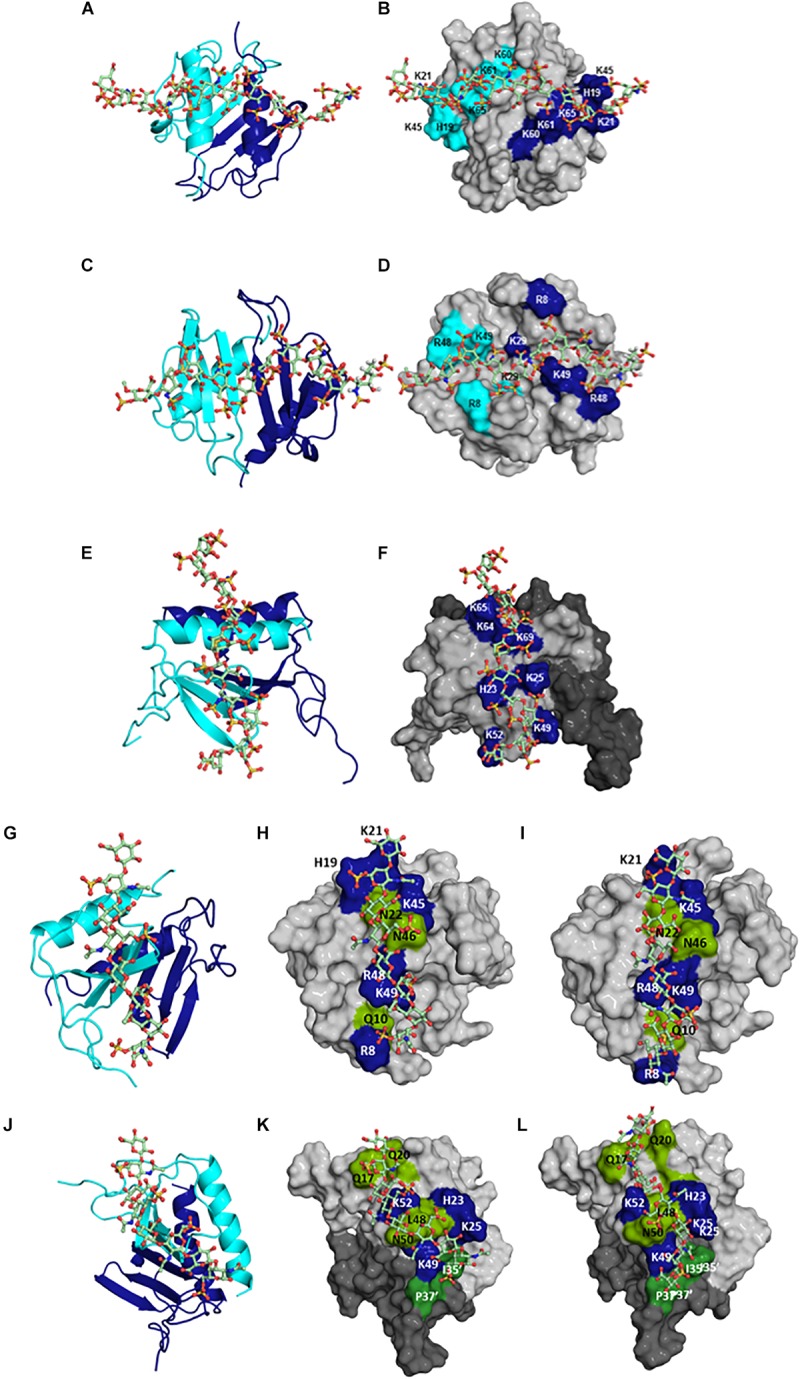
Structural models of HS bound to (A,B) CXCL1 α-domain, (C,D) CXCL1 β-domain, and (E,F) to CXCL5; of CS bound to (G,H) CXCL1 γ-domain and to (J,K) CXCL5; of DS bound to (I) CXCL1 γ-domain and to (L) CXCL5. In panels (A,C,E,G,J), CXCL1 and CXCL5 dimer structures are shown in ribbon presentation and GAG as sticks. Two monomers of the dimer are shown in blue and cyan. In panels (B,D,F,H,I,K,L), GAG binding residues are highlighted on a space-filling model. In panels (F,K,L), two monomers of the dimer are colored in light and dark gray. In panels (H–K), polar residues are in green. In panels (K,L), residues from the second monomer are distinguished by the ′ symbol. HS binds across the dimer interface in CXCL1 and within the monomer in CXCL5; CS and DS bind within a monomer in CXCL1 and bind both monomers of the dimer in CXCL5.